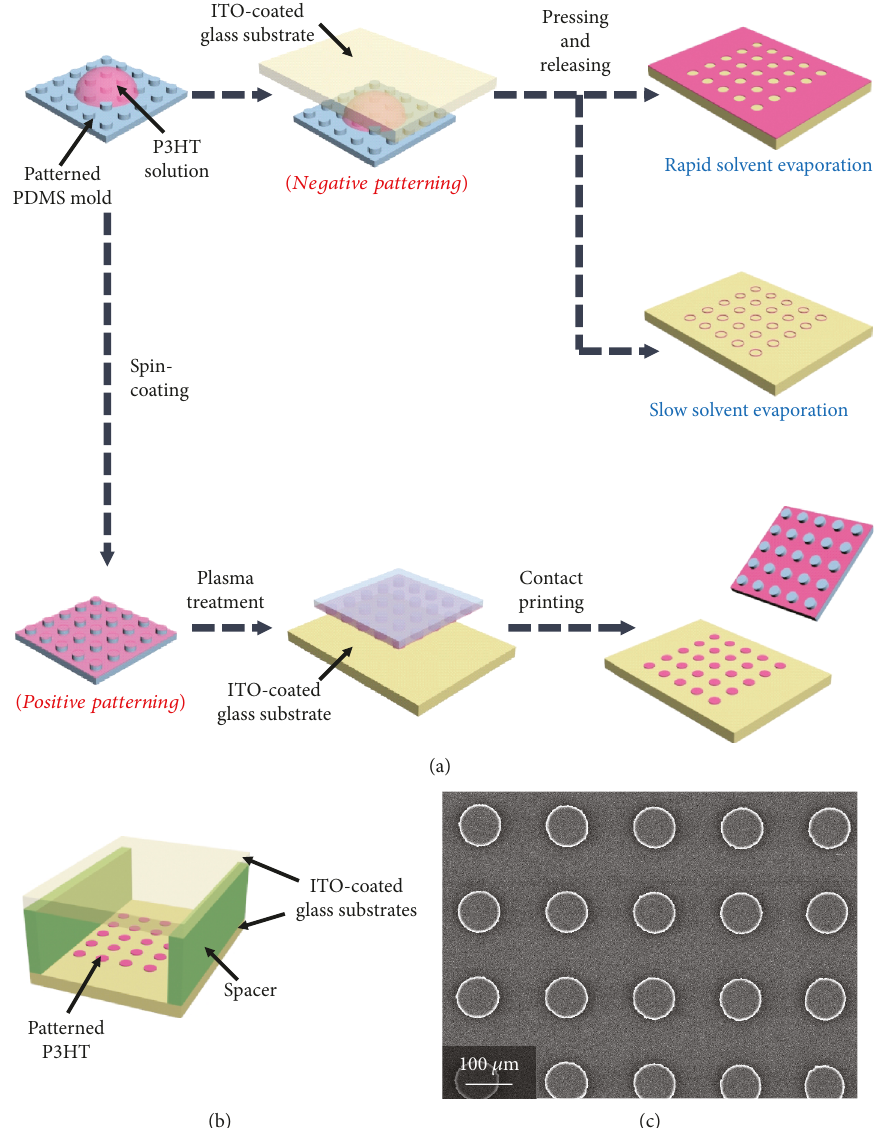
Figure 1: (a) Schematic illustration of the fabrication of patterned P3HT layers via both negative and positive patterning processes. (b) Con fi guration of EC display device. The gap space is fi lled with an electrolyte solution by capillary action. (c) SEM image of the PDMS mold with the pillar array of 100 μ m